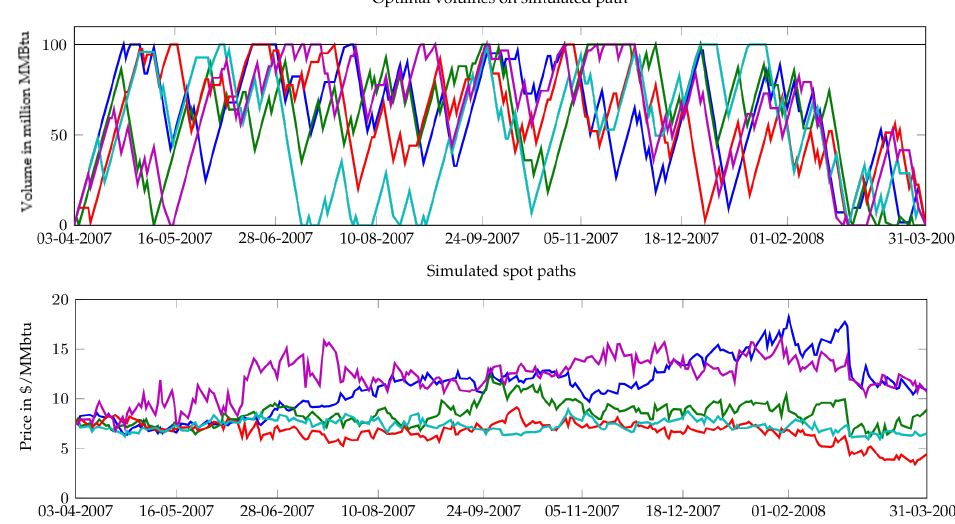
Figure 4. Valuation of a fast storage unit. For each simulated path ( bottom panel), we display ( top panel) the storage level corresponding to the optimal policy. Because of the fast injection/withdrawal speed, the storage level reacts quickly to changing market conditions.